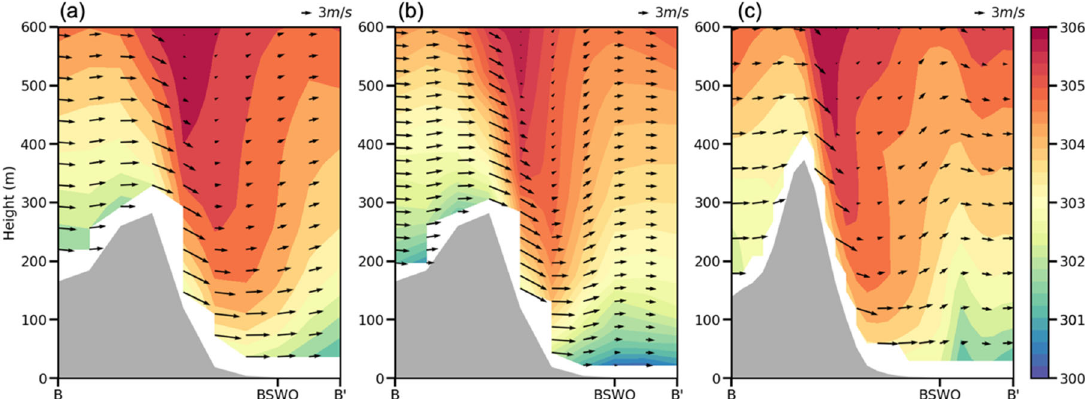
Figure 12. Vertical cross-sections of wind vectors and virtual potential temperatures at 05:30 LST along the line BB (cid:48) : ( a ) S03, ( b ) S03V, and ( c ) S04. Vertical velocity is multiplied by three. The color bar shows the virtual potential temperature